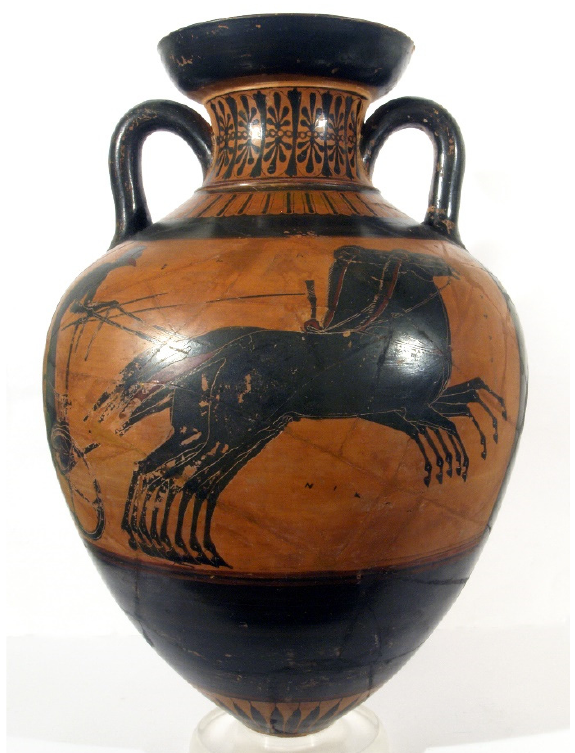
Figure 3. Pseudo-Panathenaic Amphora, Mainz, Johannes Gutenberg Universität, Figure 3. Pseudo ‐ Panathenaic Amphora, Mainz, Johannes Gutenberg Universität, 74.